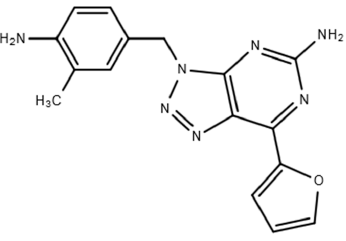
Figure 1. Structure of vipadenant.